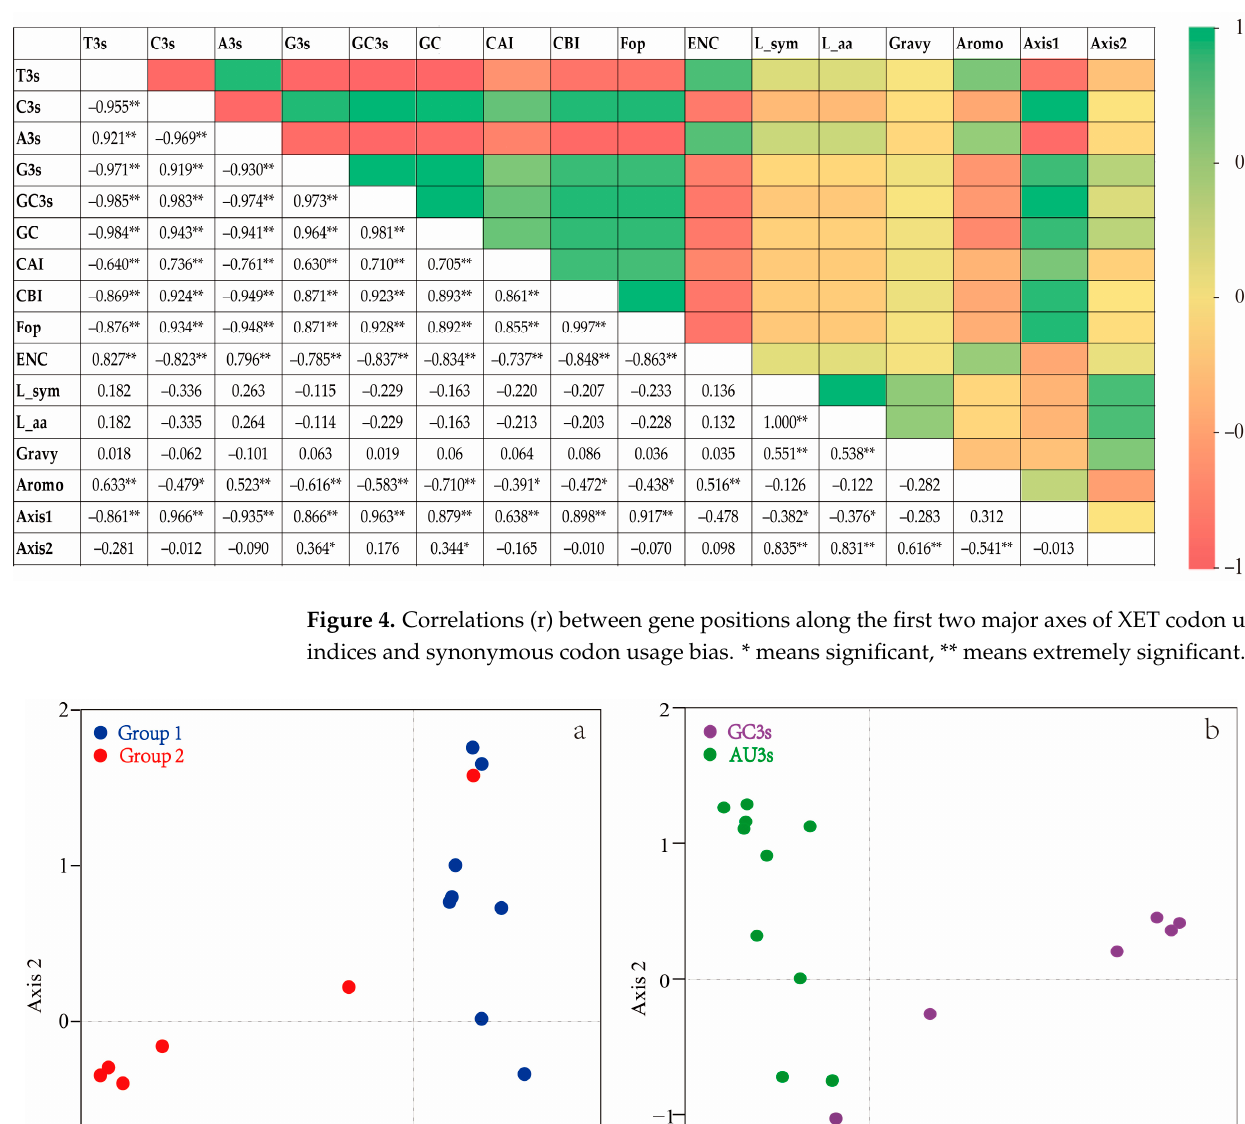
Figure 3. Correspondence analysis of the codon usage frequencies in 20 XET genes.